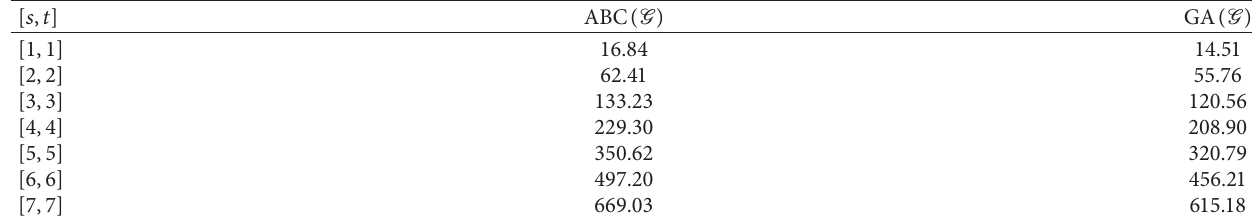
Table 2: Comparison of indices ABC ( G ) and GA ( G ) for InP [ s , t